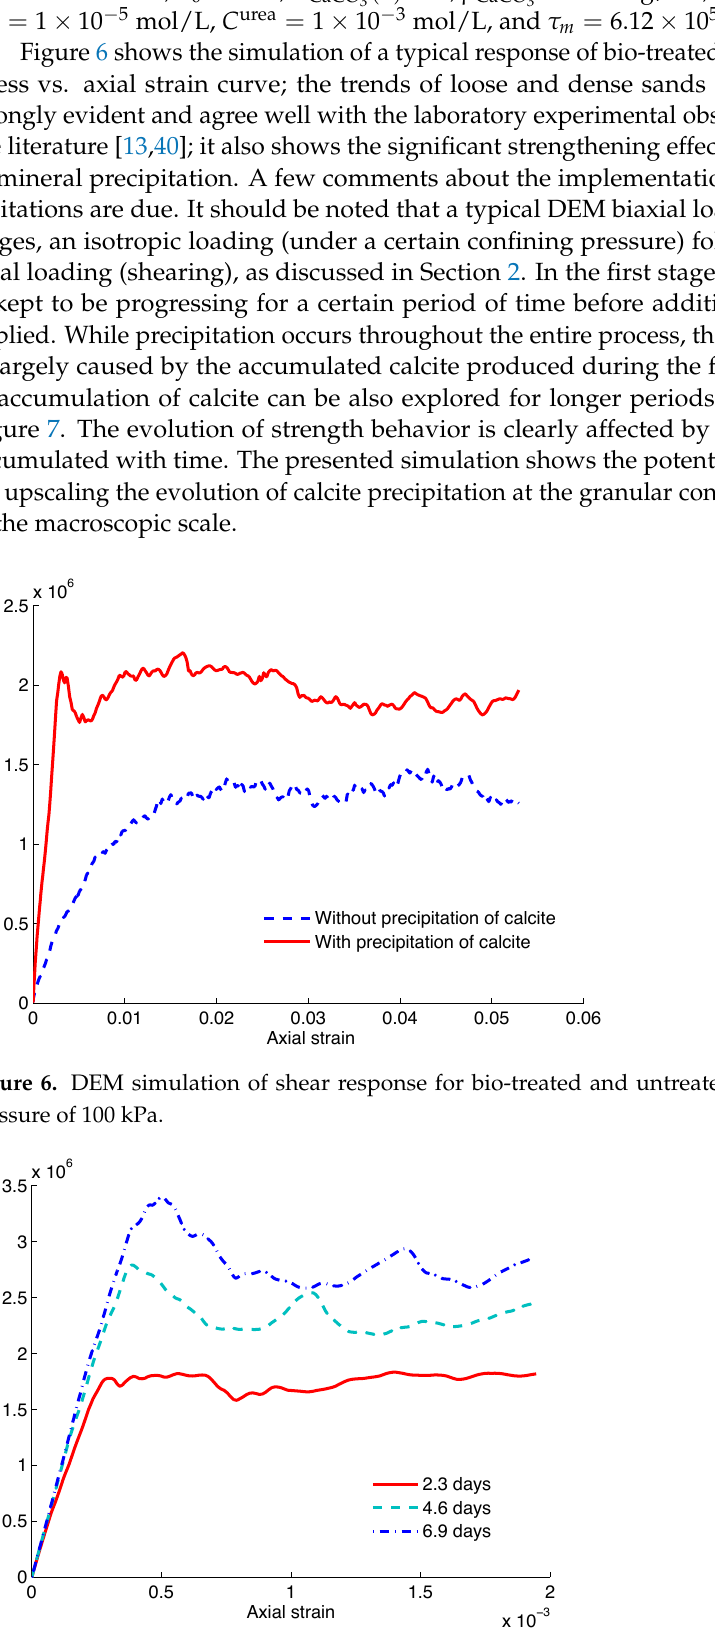
Figure 7. Simulation of shear response after different periods of time for